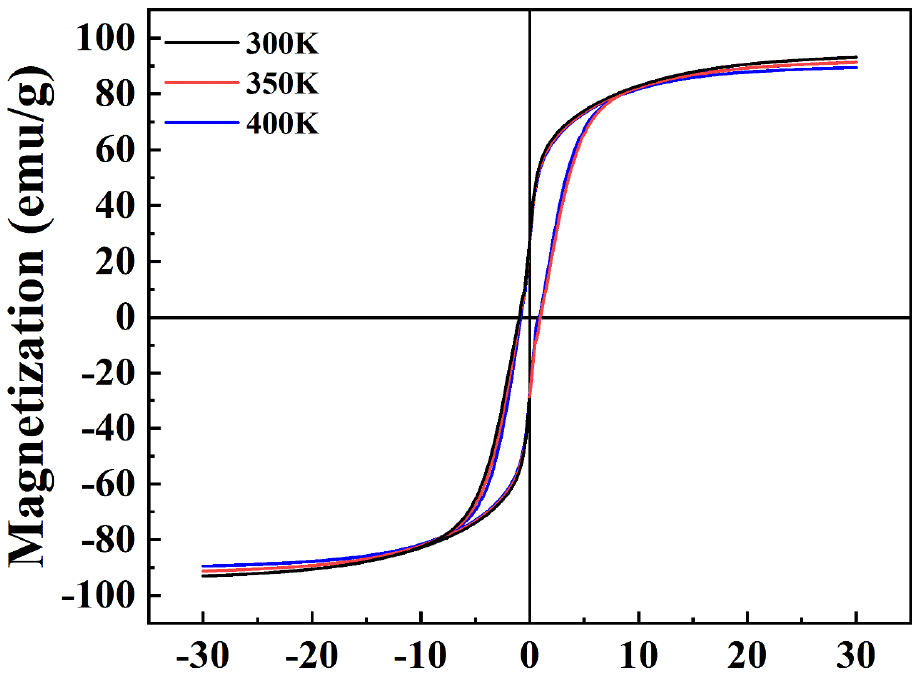
Figure 5. Magnetization hysteresis loops of Co/Fe 3 O 4 composite particles at different temperatures (300, 350, and 400 K).